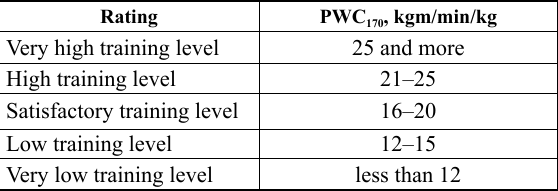
Statistics calculations. The data were calculated using computer programs Microsoft Table 2. Evaluation of physical working capacity Excel and Statistica for Windows 5.0 . Descriptive data are presented as mean and standard Rating deviation. Arithmetic averages of measurements were compared using the nonparametric Wilcoxon test and Student’s t test. The level of significance was set at 0.5.